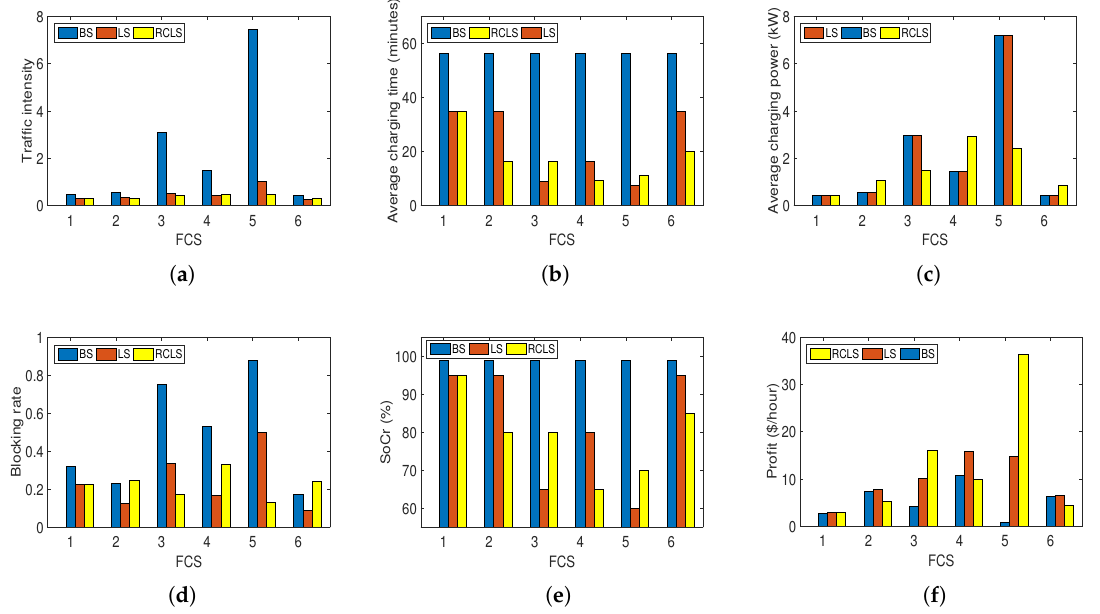
Figure 5. Performance comparison in three cases. ( a ) traffic intensity; ( b ) average charging time (minutes); ( c ) average charging power (kW); ( d ) blocking probability; ( e ) SoCr (%); ( f ) system profit